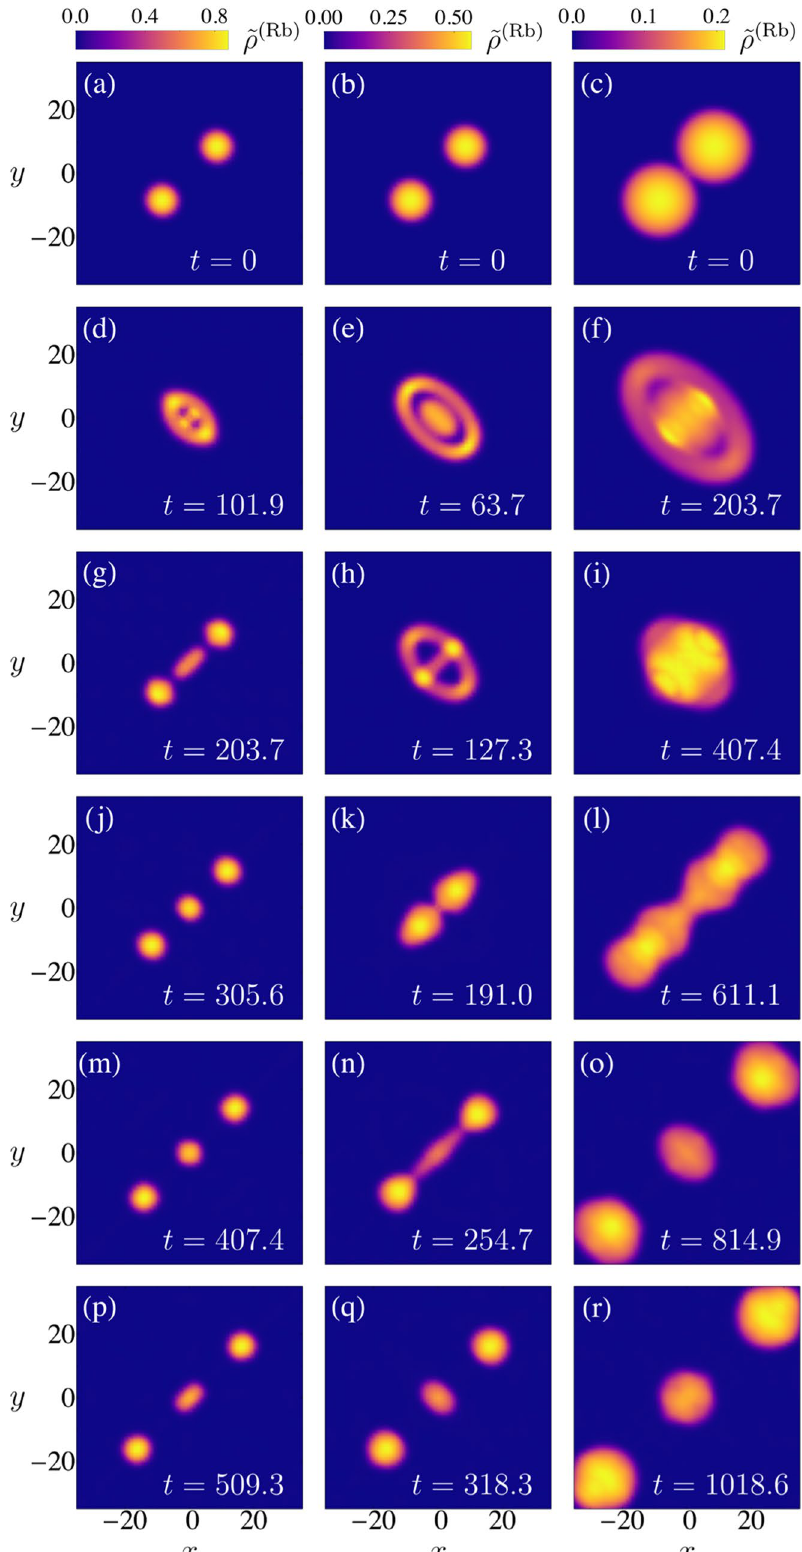
Figure 5. Illustrative examples of frontal collisions of two droplets leading to an initial coalescence followed by a disintegration of the resulting droplet into two droplets that are then expelled in opposite directions and a third droplet is formed at the center.. Initially, identical hetero-nuclear droplets of Rb and K atoms are considered in each column, where dz ρ ( Rb ) ( x , y , z ) is depicted at different evolution the density of Rb atoms integrated along the z-direction ˜ ρ ( Rb ) ( x , y ) = 5 6 times. The initial translational kinetic energy is varied to guarantee that for N Rb = 5 × 10 (first column), N Rb = 1 × 10 (cid:31) ( A 1 ) 6 31.9 (second column) and N Rb = 5 × 10 the Weber number equals We 2 =